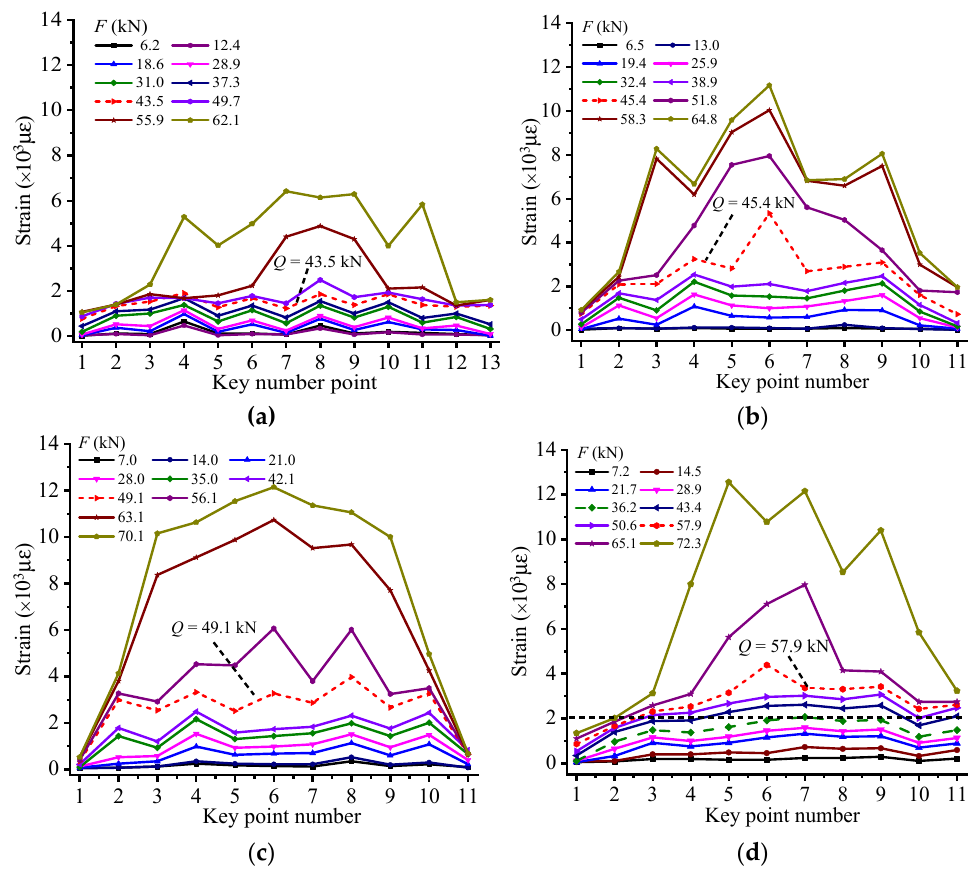
Figure 8. Strain distribution pattern of CFRP for ( a ) EG-1-0, ( b ) HG-1-3, ( c ) HG-1-6, and ( d ) HG-1-12.